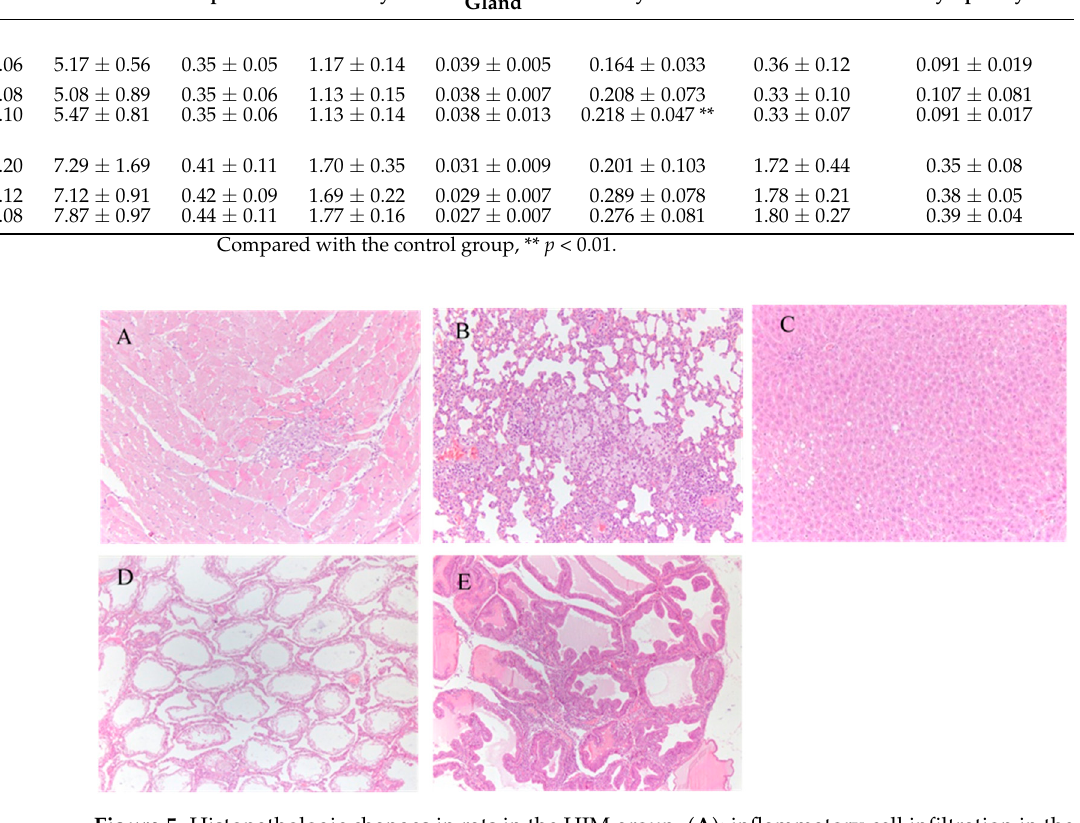
Figure 5. Histopathologic changes in rats in the HJM group. ( A ): inflammatory cell infiltration in the myocardium (HE 10 × 10); ( B ): pulmonary foam cell formation (HE 10 × 10); ( C ): liver steatosis (HE 10 × 20); ( D ): shrunken testicles (HE 10 × 10); ( E ): inflammatory cell infiltration in prostatic stroma (HE 10 × 10).